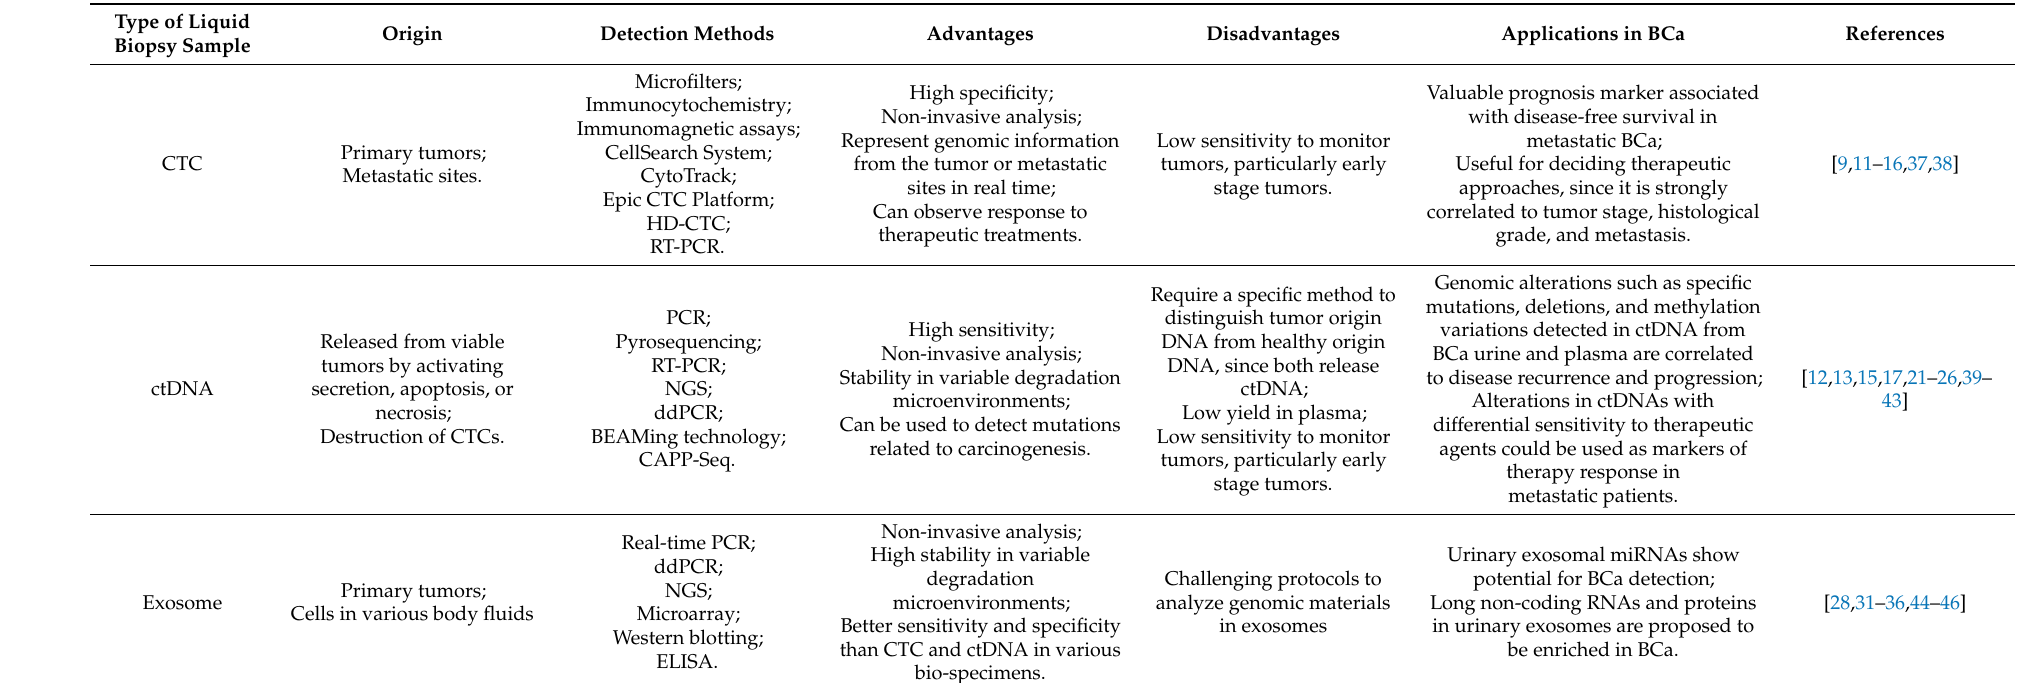
Table 1. Summary of advantages and disadvantages of liquid biopsy